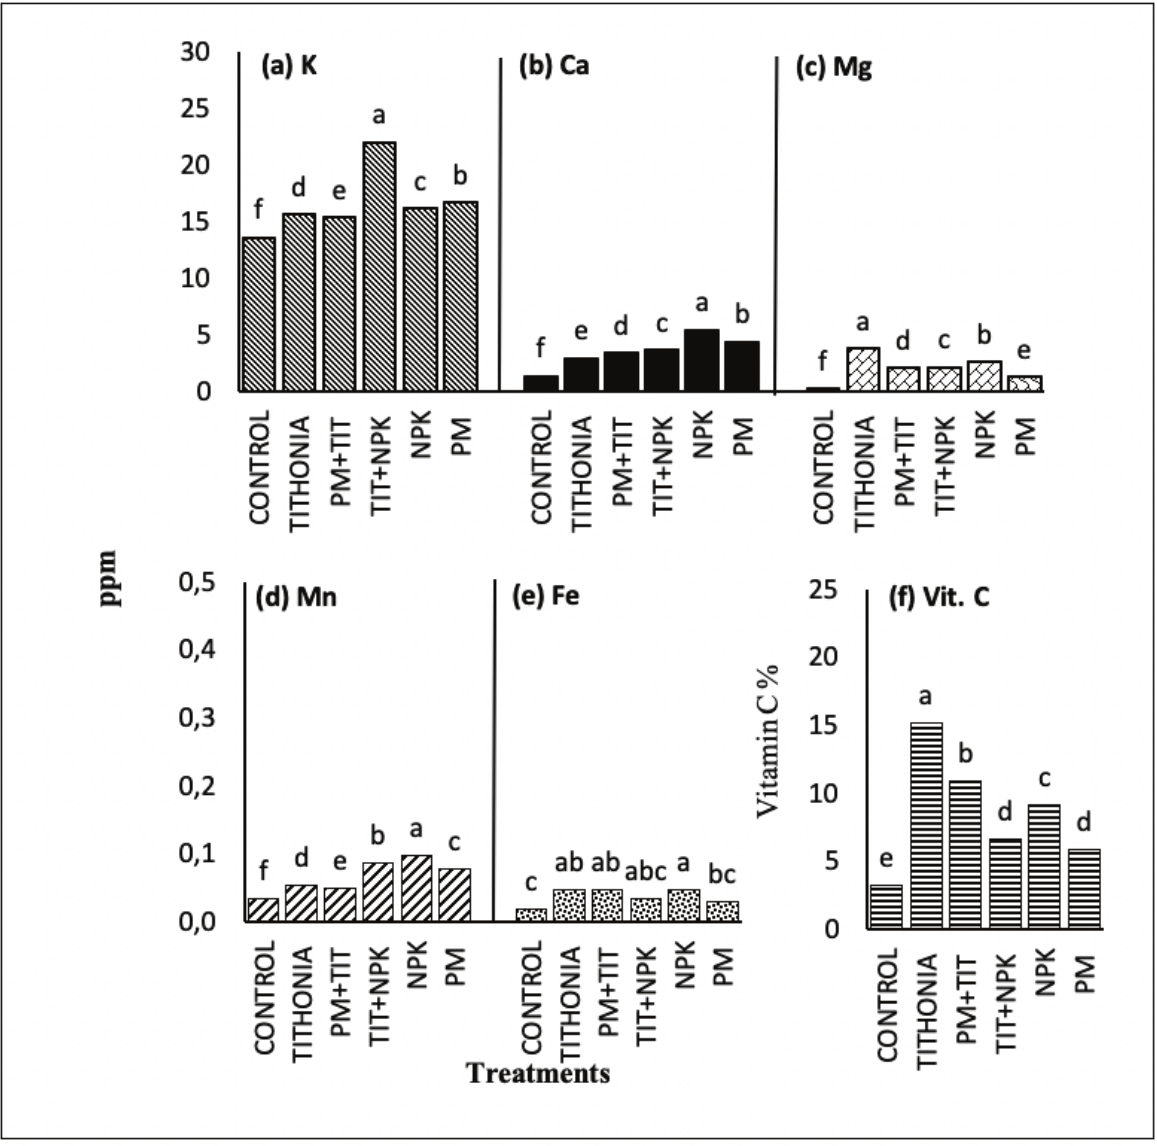
Figure 1: Effect of organic and inorganic amendment on the mineral composition and vitamin C of summer squash in 2015 and 2016 cropping season. Bars having same letter are not significantly different according to DMRT at p=0.05. PM = poultry manure, TIT = Tithonia